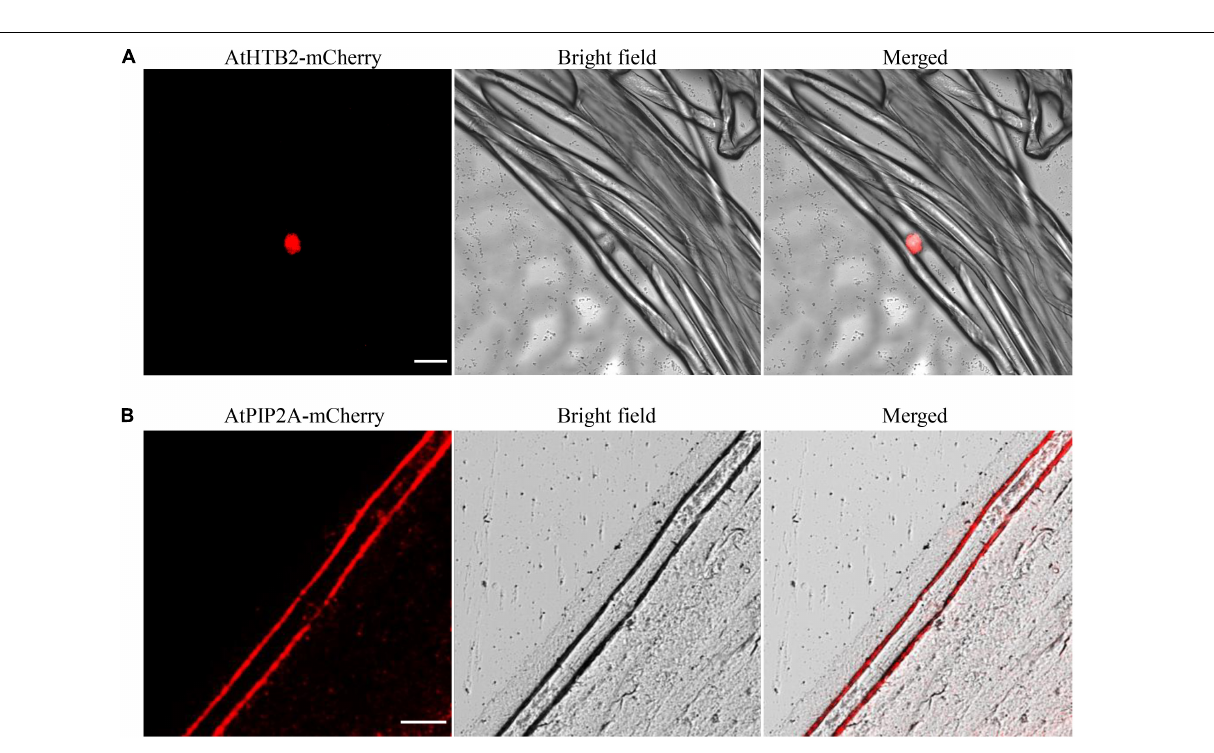
Frontiers in Plant Science |